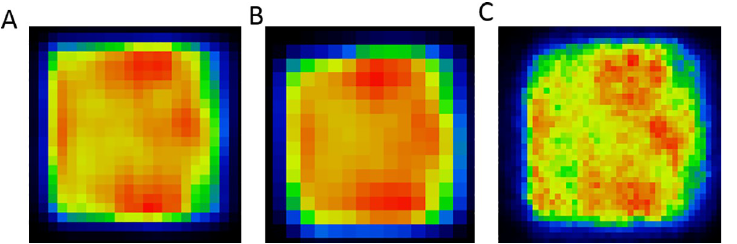
Fig 5. Representative transaxial slices of the same imitated lesion : measured and reconstructed by GE Discovery MI PET/CT (A), Mediso AnyScan PET/CT (B), Mediso nanoScan PET/MRI (C).